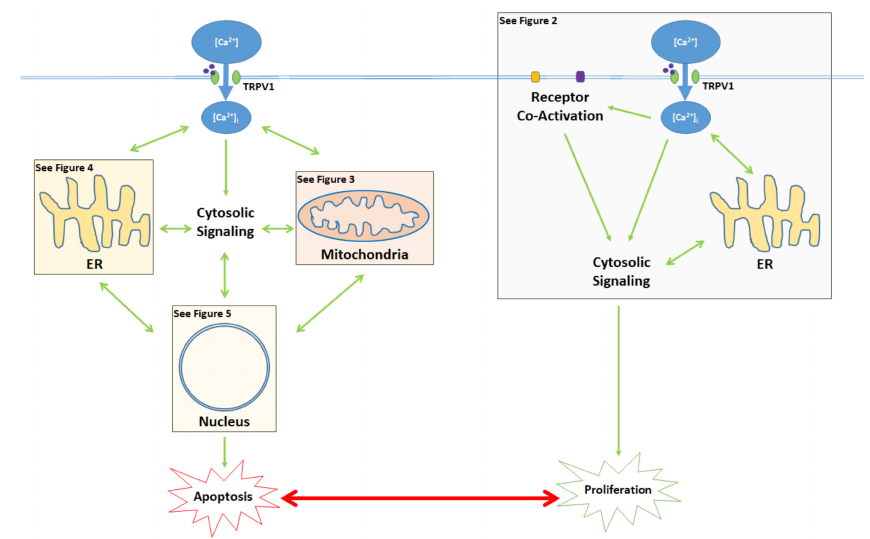
Figure 1. Activation of the TRPV1 ligand-gated ion channel causes Ca 2 + influx into the cytosol and influences the balance between proliferation and apoptosis. Apoptotic signaling occurs through the cytosol, mitochondria, endoplasmic reticulum (ER), and the nucleus. In contrast, the proliferative e ff ects of TRPV1 are mediated by the activation of other cell membrane receptors, ER signaling, and cytosolic protein signaling cascades. The proliferative, proapoptotic mitochondrial, proapoptotic ER, and proapoptotic nuclear signaling mechanisms are highlighted in the colored boxes, and specified in Figures 2–5, respectively.